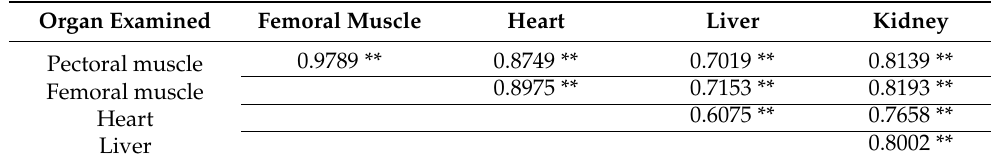
Table 4. Correlation coefficients between Hg concentrations in the Eurasian magpie organs analyzed.